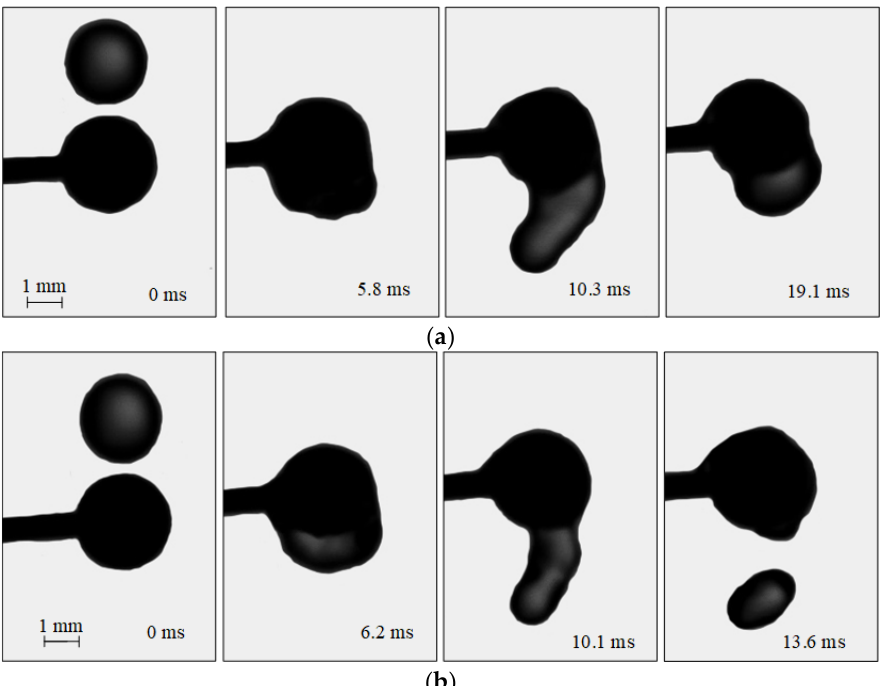
Figure 3. Images illustrating the collisions of water droplets with a particle: ( a )—agglomeration ( R d = 2.15 mm; R p = 3 mm, U d = 2.67 m/s); ( b ) — stretching separation ( R d = 2.2 mm; R p = 3 mm, U d = 3.2 m/s).